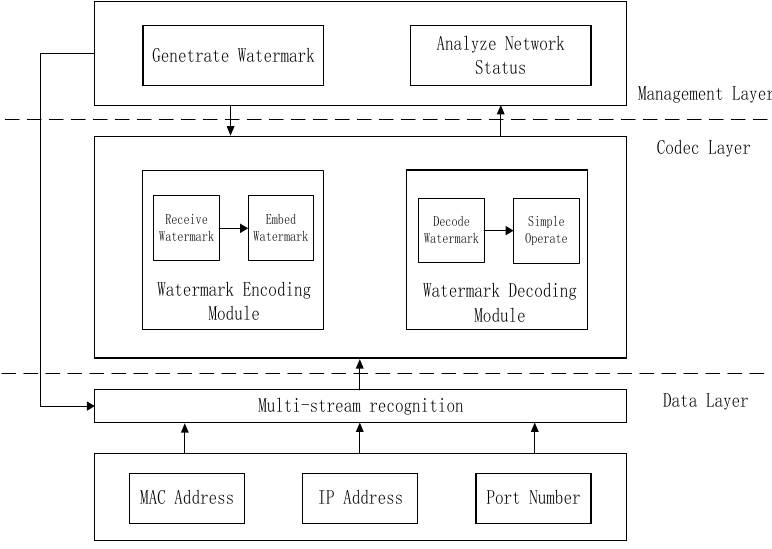
Figure 2. The network congestion detection model based on flow watermarking.